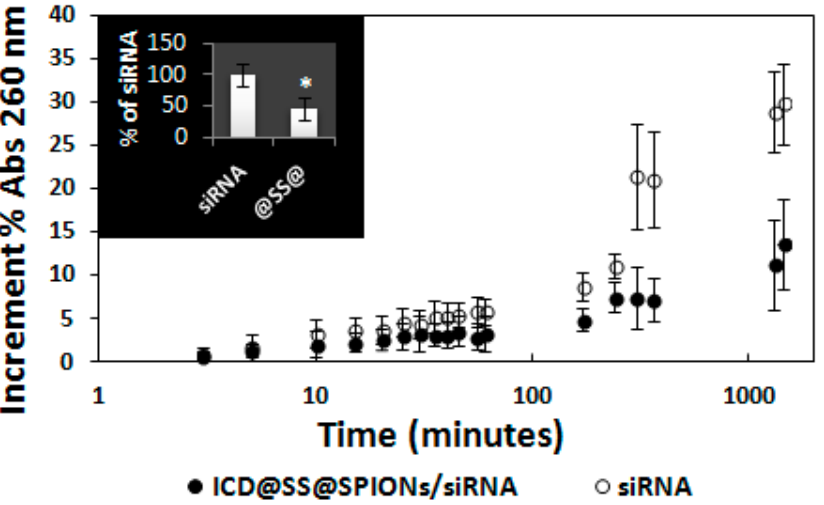
Figure 9. Increments (%) in absorbance at 260 nm of ICD@SS@SPIONs/siRNA dispersion as a function of time. Necked siRNA is reported as positive control. Insert in figure represents